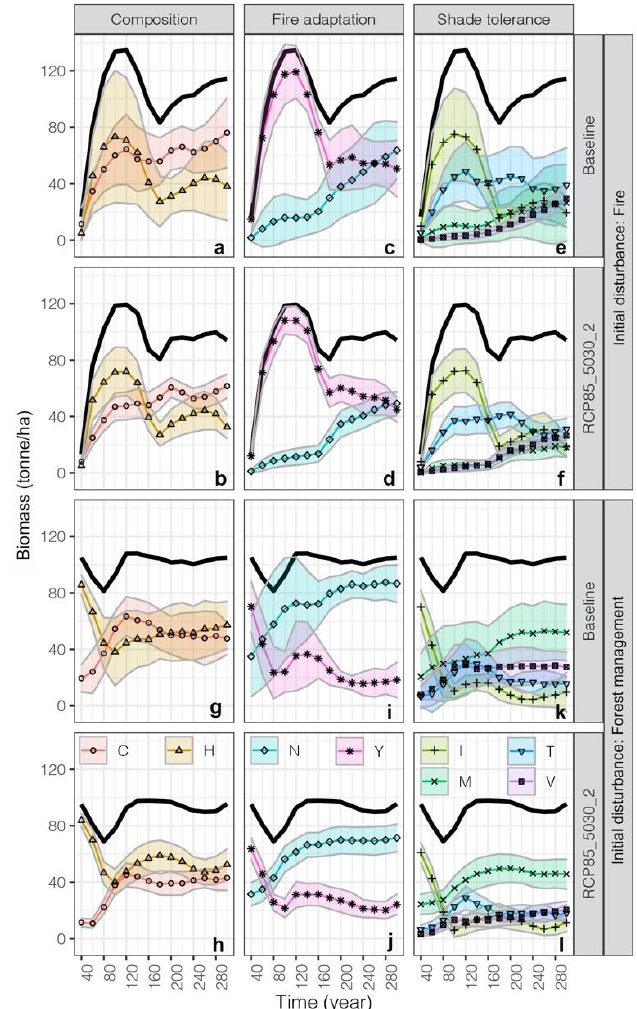
Figure 2. ( a – l ) Successional pathways of aboveground biomass (AGB, tonne/ha) in the Boreal Forest of Quebec of the functional characteristics groups of tree species in relation to fire and forest management over the simulation period for the Baseline and RCP 8.5 5030_2% scenarios. Left column: Species composition; H, group of hardwood species and C, group of conifer species (see hardwood species and conifer species considered in Table 2). Middle column: Species fire adaptation; Y, group of species with fire adaptations; and N, group of species without fire adaptations. Right column: Species shade tolerance; I, group of shade-intolerant species; M, group of species with moderate shade tolerance; T, group of shade-tolerant species; and V, group of very shade-tolerant species. The solid black line represents the total AGB (tonne/ha). Shaded areas around the mean AGB over time for the various functional characteristic groups correspond to the mean standard error.